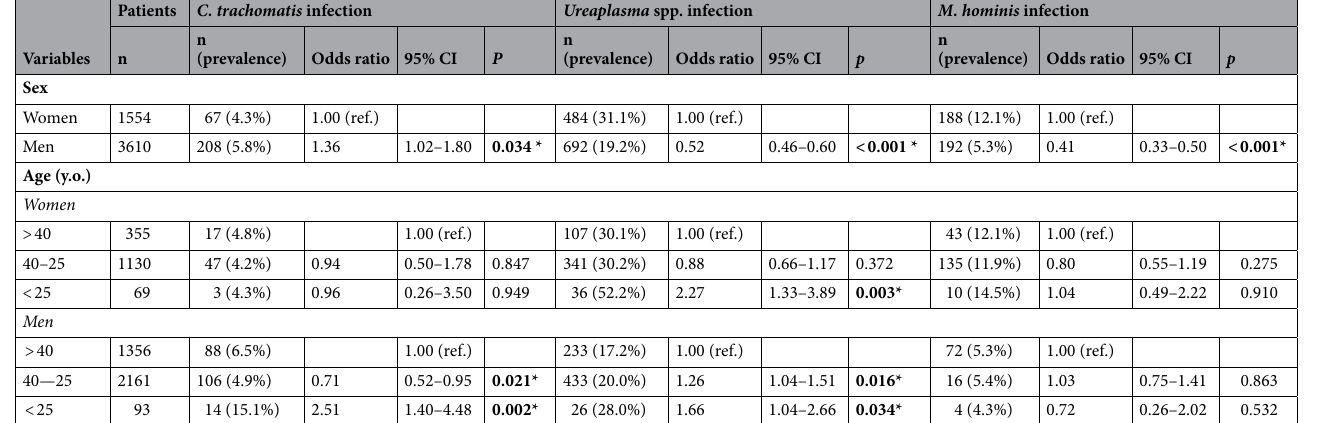
Table 2. Prevalence of infections in patients with couple’s primary infertility according to sex and age. Univariate analysis. 95%CI: 95% confident interval. A * p < 0.05 was considered statistically significant. Bold p numbers mean those which are statistically significant